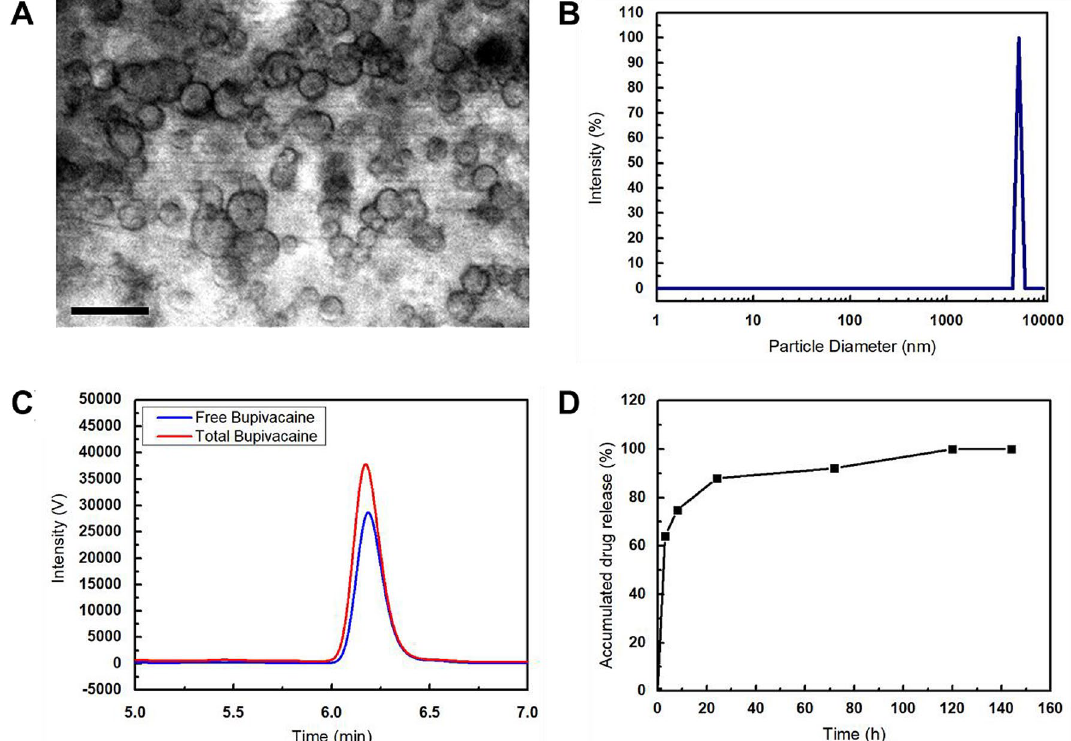
Figure 1. Characterization and in vitro pharmacokinetic study of bupivacaine-loaded liposomes. ( A ) Light microscope of bupivacaine-loaded liposomes at 500× magnification. Scale bar = 5 µm. ( B ) Particle size distribution of bupivacaine-loaded liposome suspension. ( C ) Chromatogram of free bupivacaine (blue) and total bupivacaine (red) for estimating encapsulation efficiency. The bupivacaine was monitored using UV detector at 262 nm. ( D ) In vitro release profile of bupivacaine-loaded